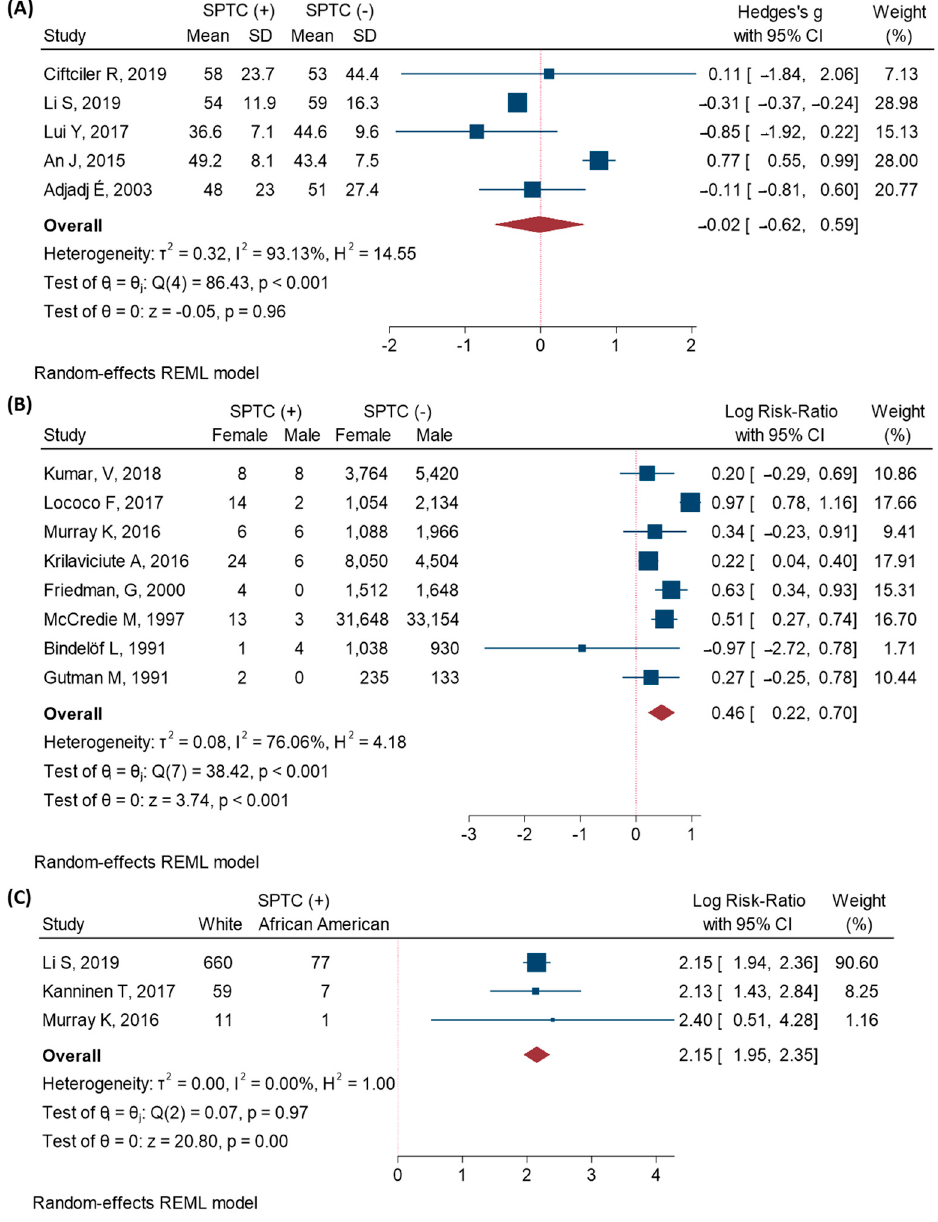
Figure 4. Characteristics of the SPTC patients. Random-effects model with restricted maximum- likelihood method was used. ( A ) Age, reported as standardized mean difference; ( B ) Gender, reported as log risk ratio; ( C ) Race, reported as log risk ratio.